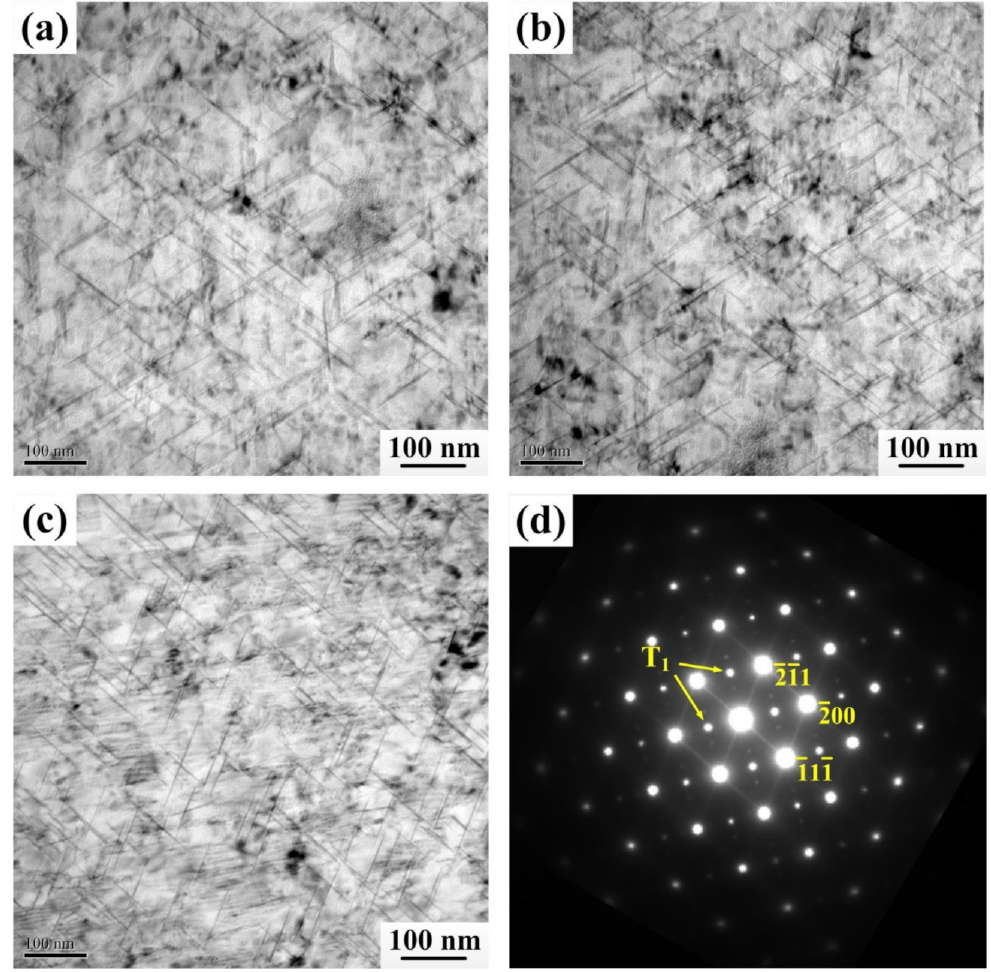
Figure 6. TEM images of Al-Cu-Li alloys manufactured by different processes after aging: ( a ) casting; ( b ) TRC; ( c ) electro- magnetic TRC; ( d ) electron diffraction